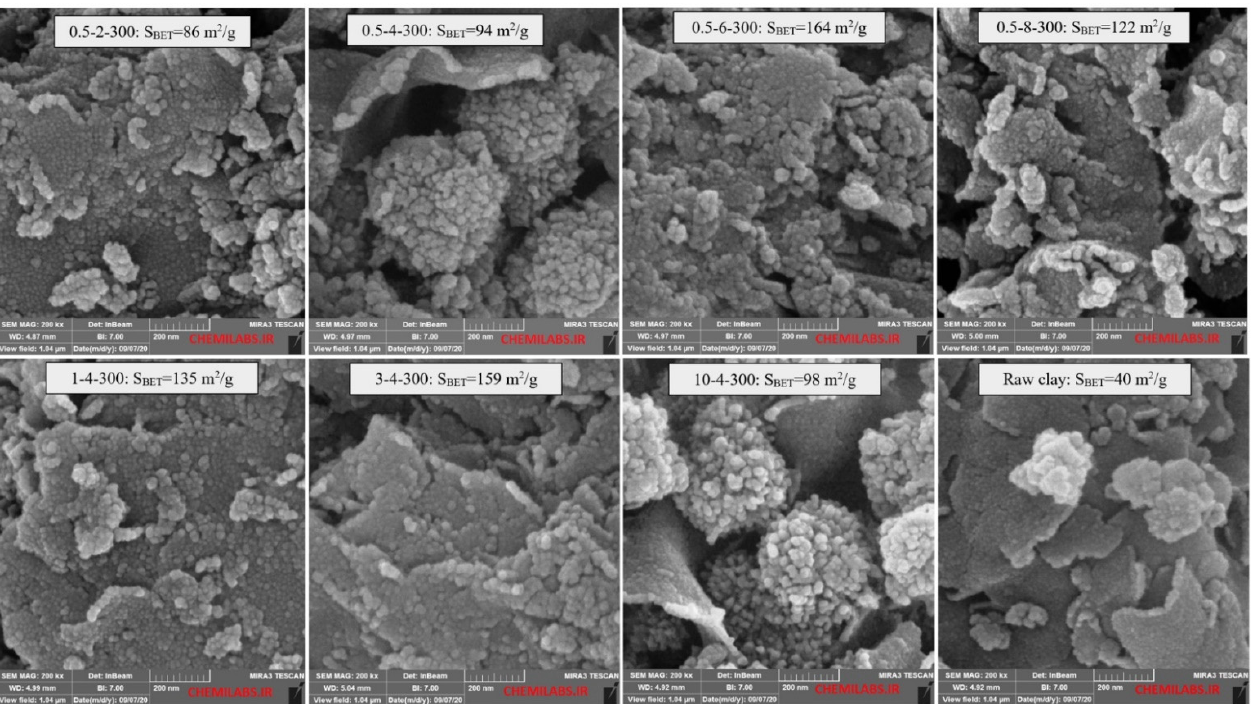
Figure 9. FESEM micrographs of natural and Ti-pillared clays prepared under different conditions.